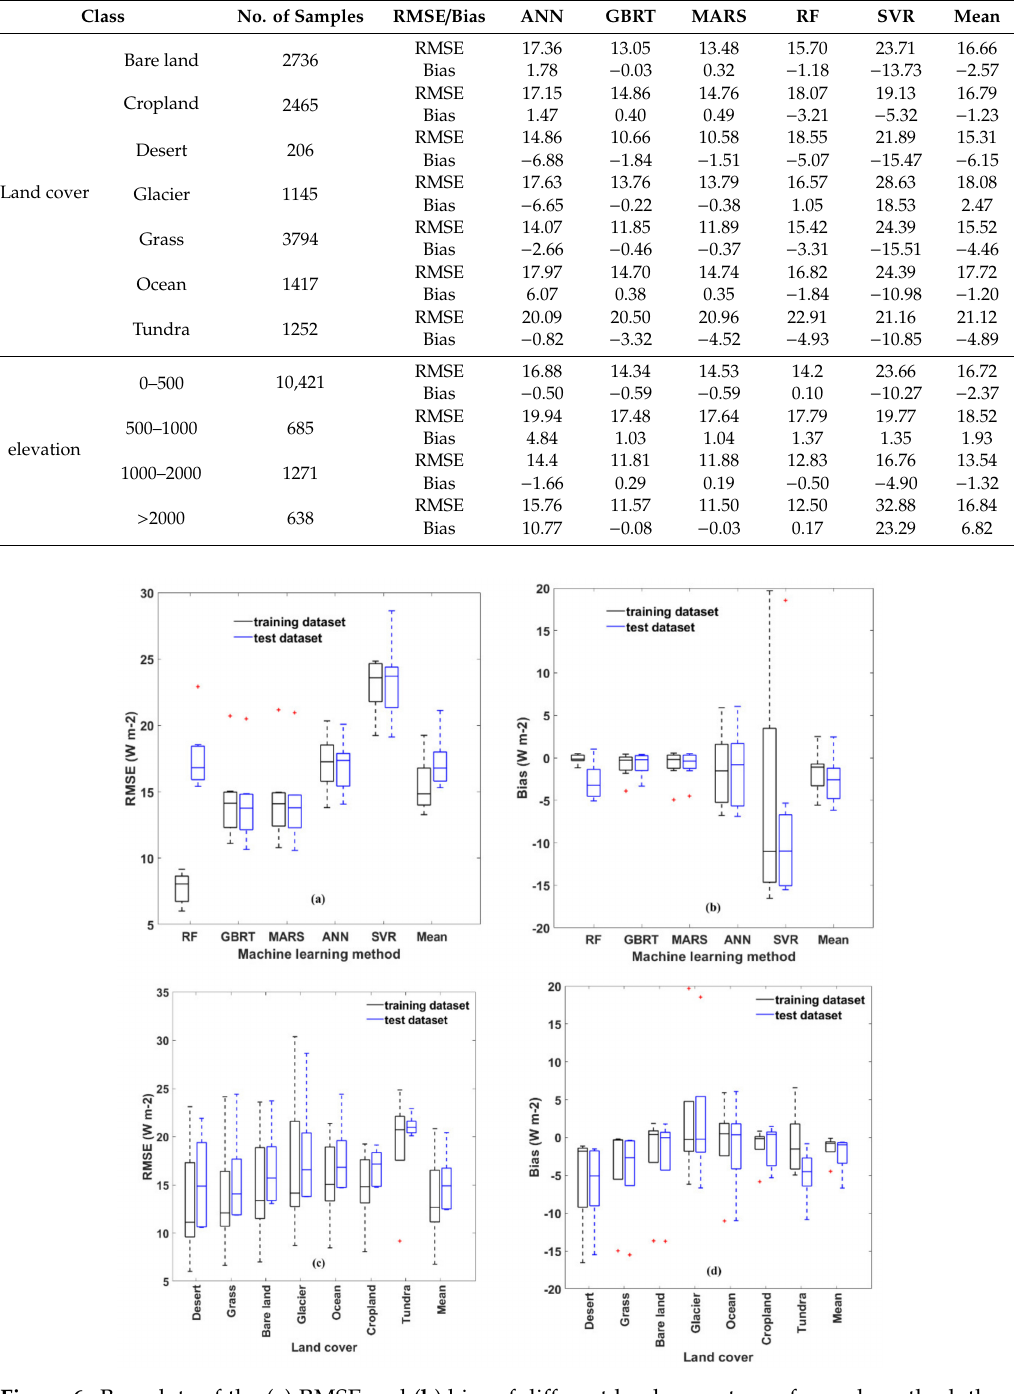
Figure 6. Box plots of the ( a ) RMSE and ( b ) bias of di ff erent land cover types for each method; the ( c ) RMSE and ( d ) bias of di ff erent machine learning methods over each land cover type. The middle line within the box represents the median value. The red asterisks represent the